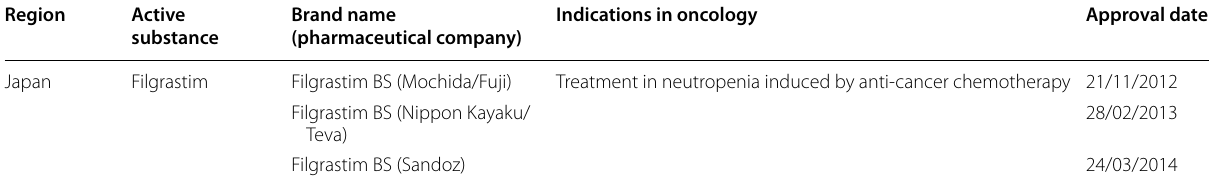
Table 6 Key studies of biosimilar filgrastim that demonstrated clinical equivalence to the reference drug Active substance Brand name